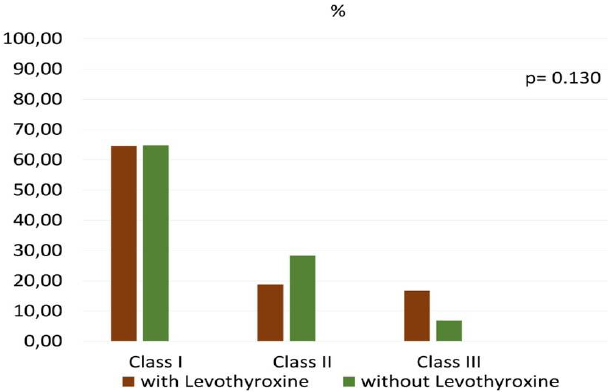
Figure 1. Prevalence of the different obesity classes according to Levothyroxine use .